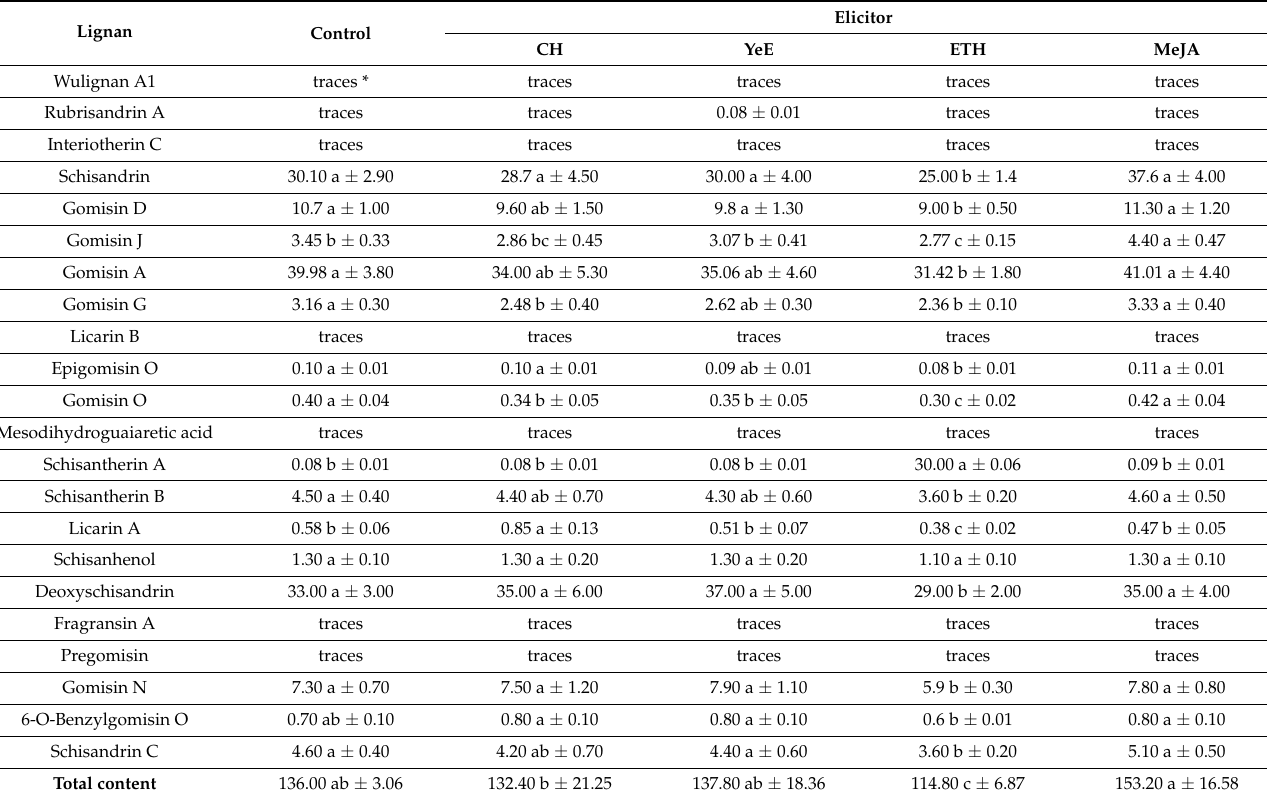
Figure 3. Biomass gains of control and elicited in vitro cultures of S. rubriflora grown in Plantform bioreactors. Data expressed as the mean value ± SD ( n = 3). Different superscript letters (a–c) within a row indicate significant differences between means (Duncan’s multiple range test; p < 0.05). Table 8. Content (mg/100 g DW ± SD) of lignans in extracts from S. rubriflora microshoot cultures grown in Plantform bioreactors; control and elicited. Data expressed as the mean value ± SD ( n = 3). Different superscript letters (a–c) within a row indicate significant differences between means (Duncan’s multiple range test; p <